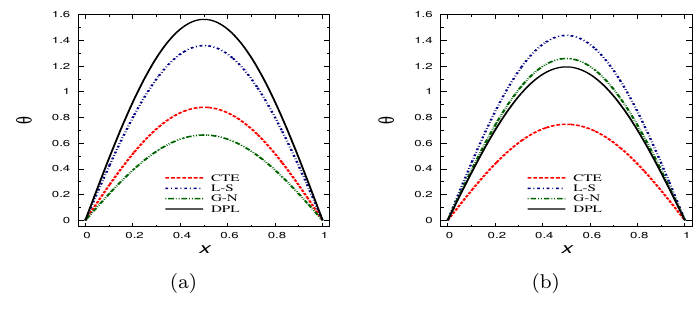
Figure 2. The temperature distributions in the axial direction for beams under (a) thermal load and (b) thermomechanical load. Figure 2 shows the variation of the dimensionless temperature θ along the axial direction at the bottom surface z = − 0 . 5 of the beam under ( a ) thermal load and ( b ) thermomechanical load. The behaviors of all models may take different shapes. The maximum temperature occurs at the center of the